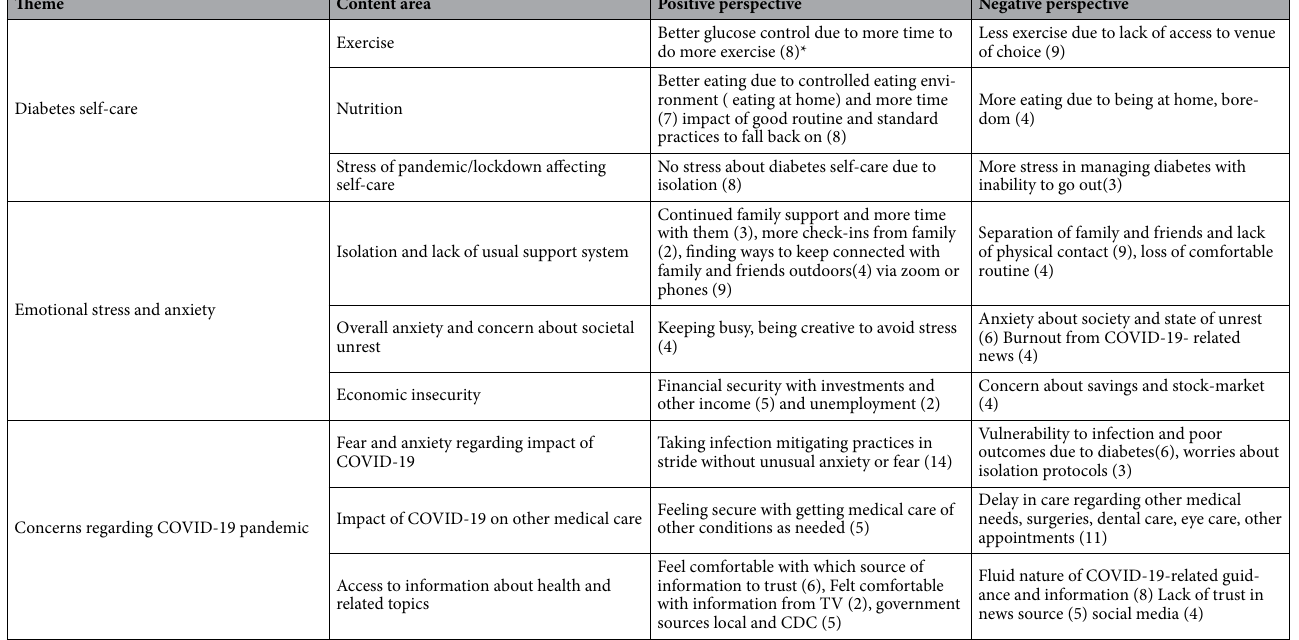
Table 2. Themes and subthemes of impact of isolation during pandemic on self-management and psychosocial aspects. *Number of people in the study who discussed each perspective listed in